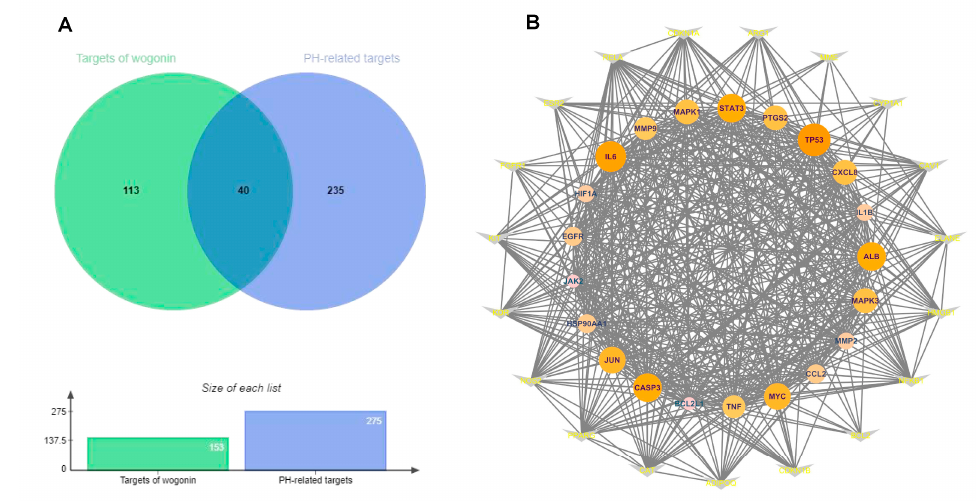
Figure 2. PPI network analysis of potential therapeutic targets of wogonin against PH. ( A ) The 40 intersection genes of wogonin and PH-related targets. ( B ) The PPI network of the 40 targets. the protein with higher degree was presented with larger node and darker color. The nodes in the inner circle are the core targets in the network. The color intensity of a node is proportional to the value of a degree in the network.